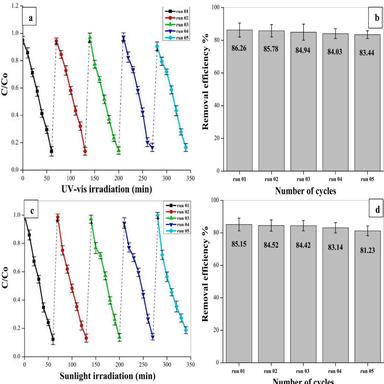
Cyclic stability and reusability of Alg/CuO-gC₃N₄ under (a & b) UV–vis (c & d) Sunlight irradiation.